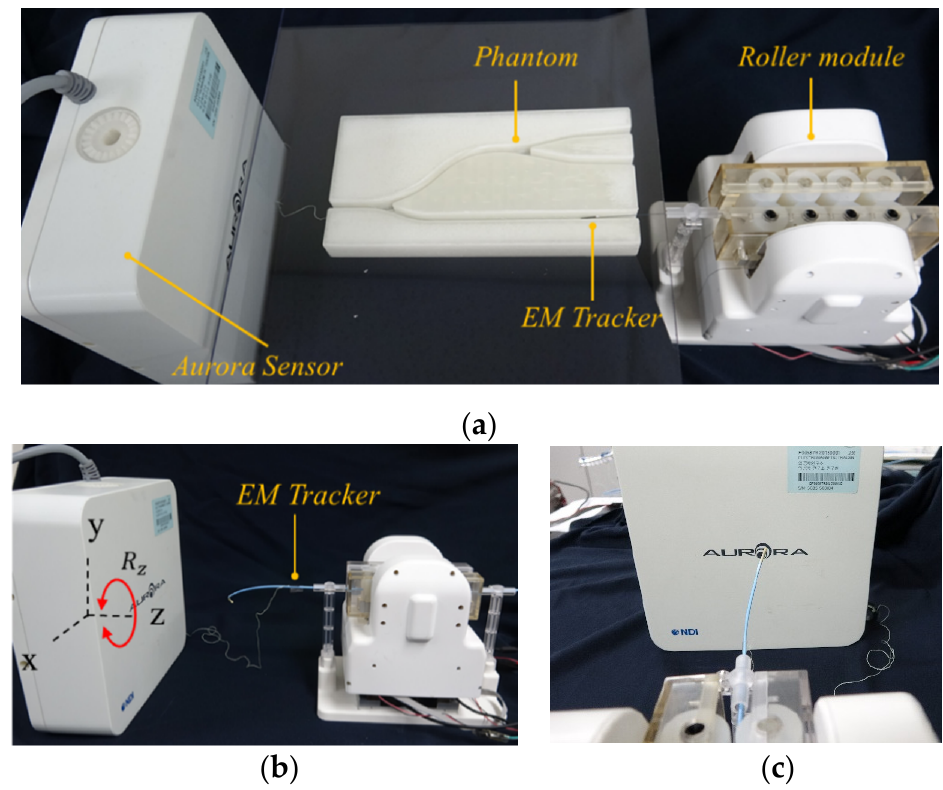
Figure 11. Experimental setup for ( a ) translational motion, ( b ) rotational motion, ( c ) rotational motion in the front view.